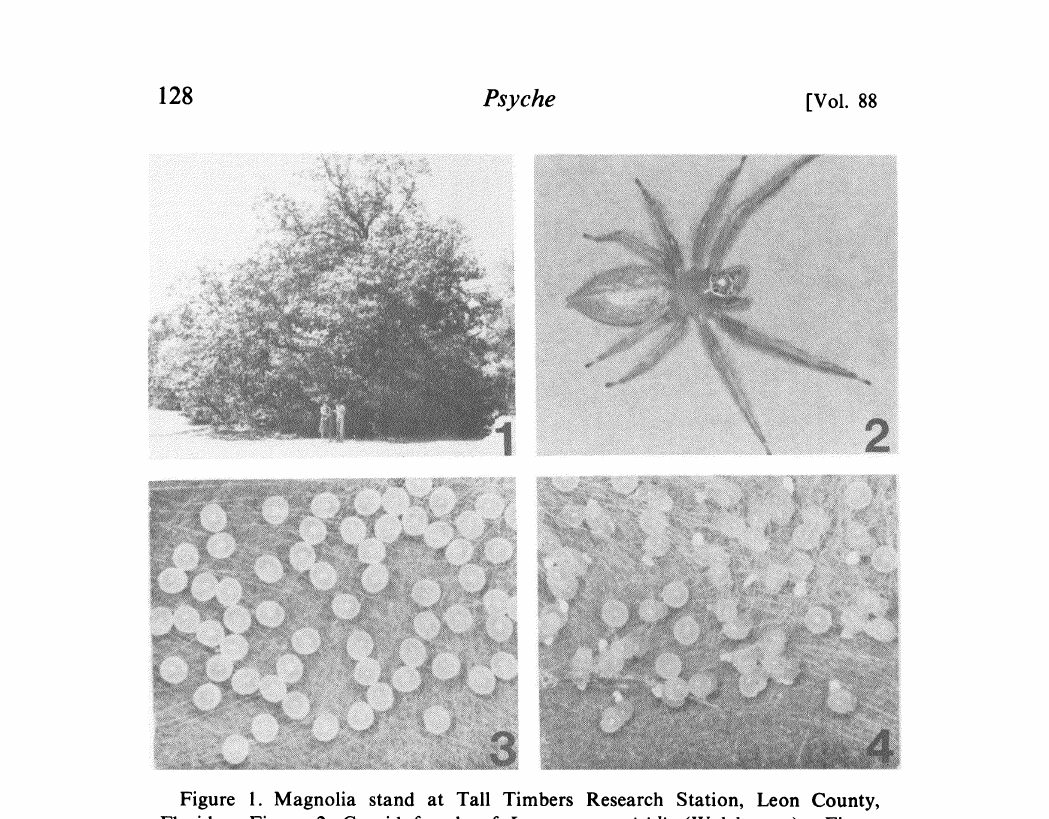
Figure 1. Magnolia stand at Tall Timbers Research Station, Leon County, Florida. Figure 2. Gravid female of Lyssomanes viridis (Walckenaer). Figure 3. Eggs of Lyssomanes viridis on underside of magnolia leaf. Figure 4. First postembryos of Lyssomanes viridis on magnolia